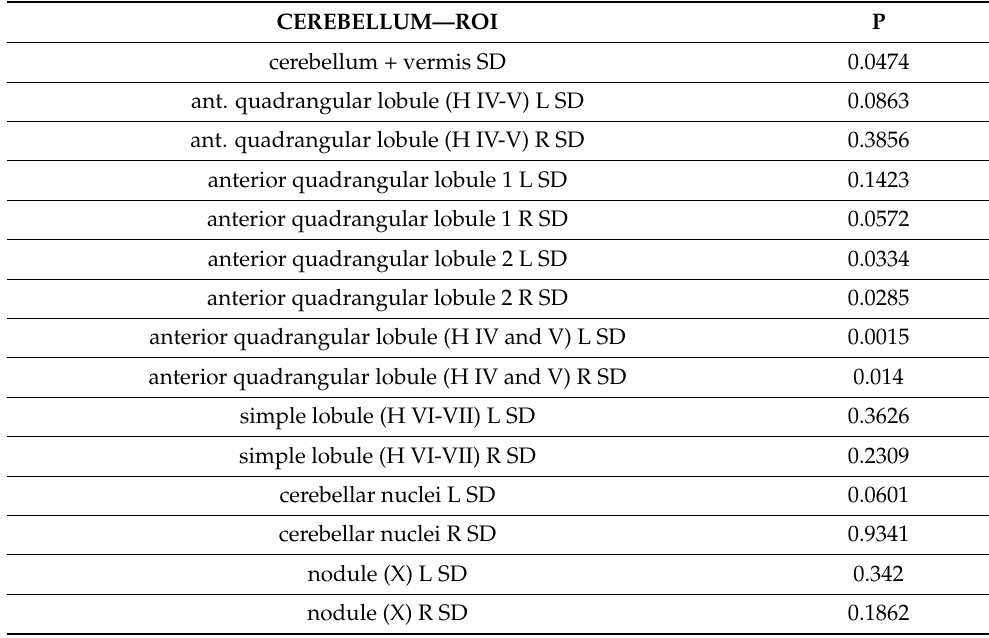
Table 3. Comparison of MSA-P and PSP-P groups of patients in regard to cerebellum SPECT